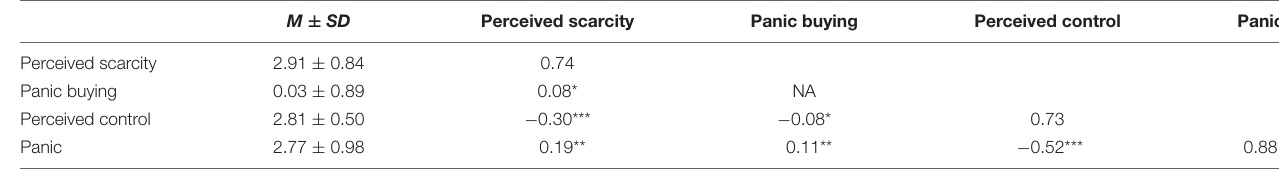
TABLE 2 | Descriptive statistics and correlations among variables assessed in Study 2.